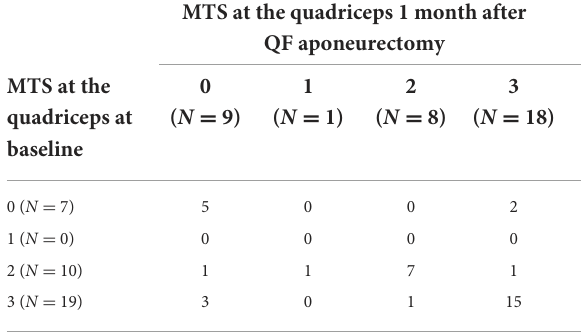
TABLE 3 Two-way table of MTS scores in the CTRL group ( N = 36) at baseline and 1 month after surgery inclusive of QF aponeurectomy.